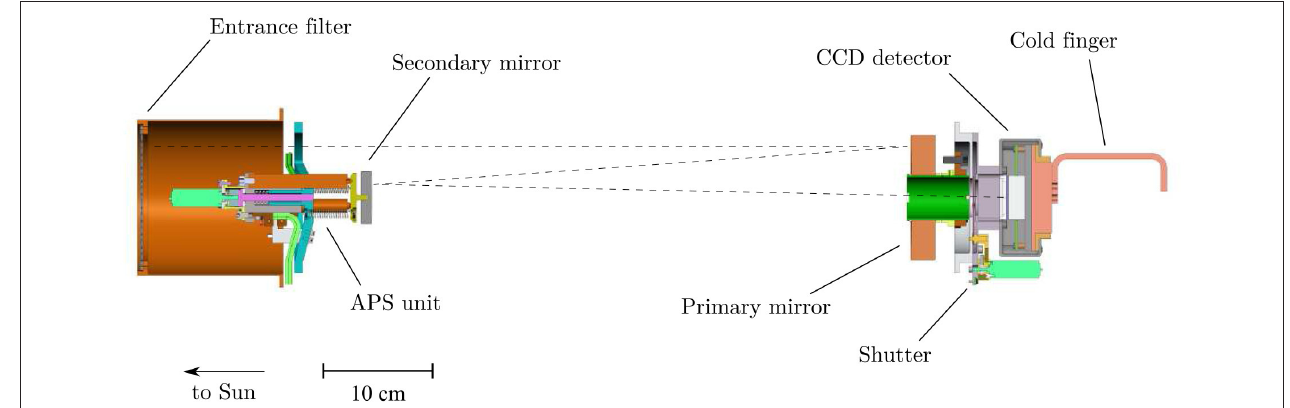
FIGURE 2 | A cross sectional view of the EUV telescopes inside the KORTES-SU assembly. The three KORTES telescopes share the same Ritchey-Chretien optical design with 113 mm aperture and 1,740 mm effective focal length. The secondary mirrors feature an active positioning system (APS) to enable fine pointing and stabilization.